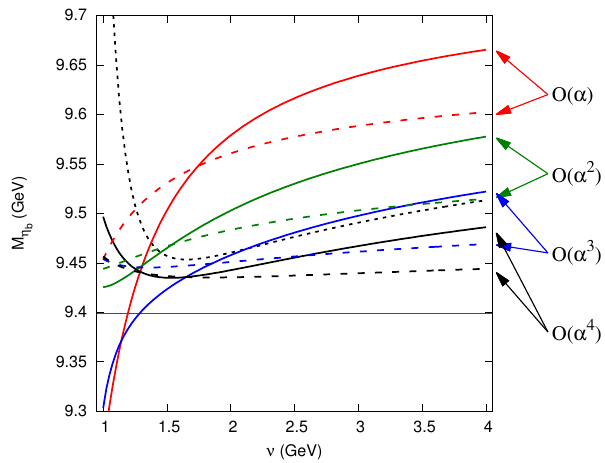
Figure 8 . Plot of 2 m b + E (0) for bottomonium using V (0) for N = 0, 1, 2, 3 with (cid:23) f = 1 GeV. 10 N; RS 0 The red horizontal line is the experimental value. Continuous lines are evaluated with (cid:23) r = 1 and dashed lines with (cid:23) r = 1 GeV. The dotted line stands for the N = 3 evaluation in strict weak coupling (truncating the sum at O ( m(cid:11) 5 s